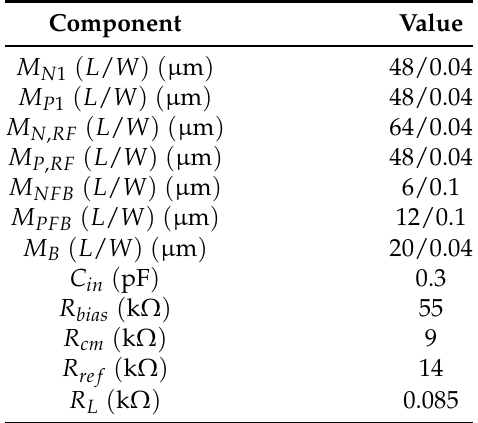
Figure 13. Double balanced mixer with complementary LO switching and g m -stage ( left ); and common- mode feedback circuit ( right ). Table 2. Mixer transistor sizing and component